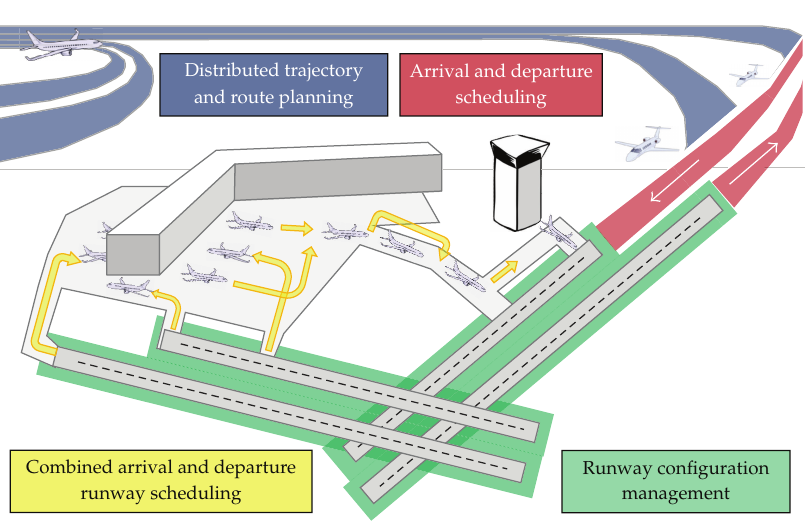
Figure 3: Typical Air Transportation System